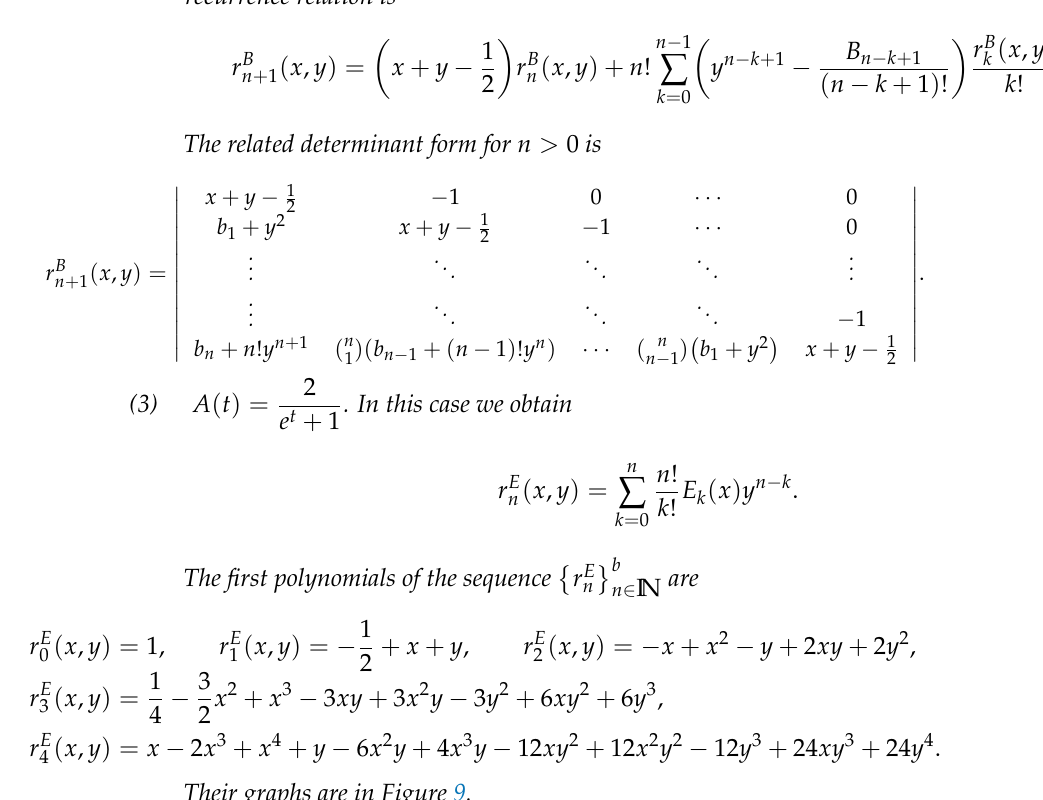
, i = 1, . . . ,4, in [ − 1,1 ] × [ − 1,1 ] i